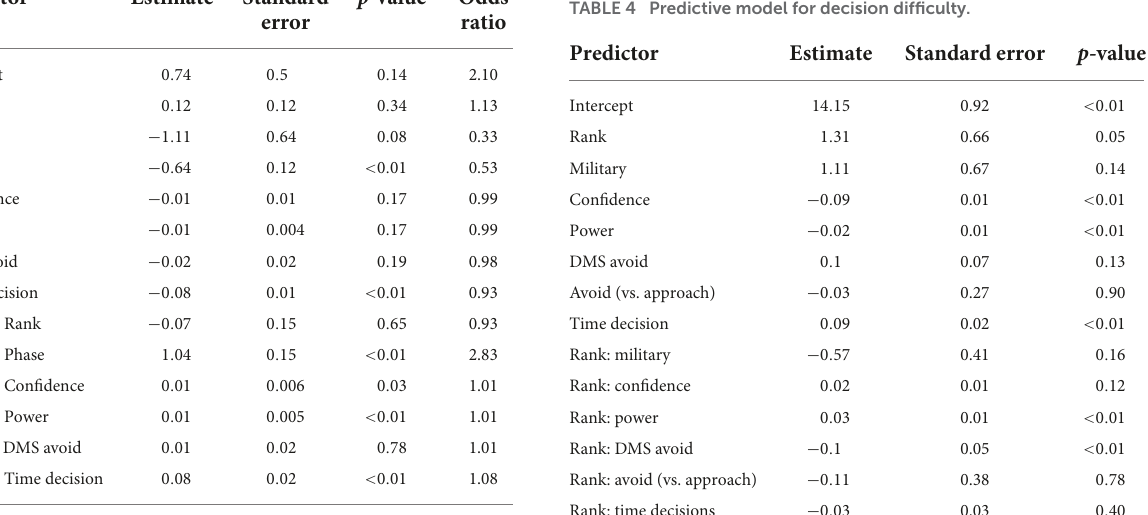
TABLE 4 Predictive model for decision